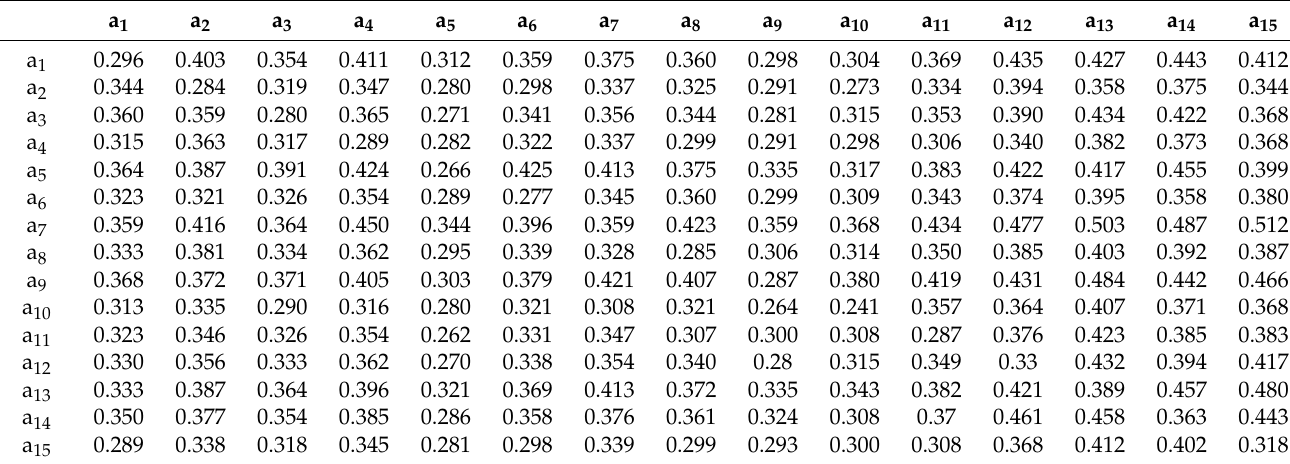
Table A1. Composite impact matrix C .